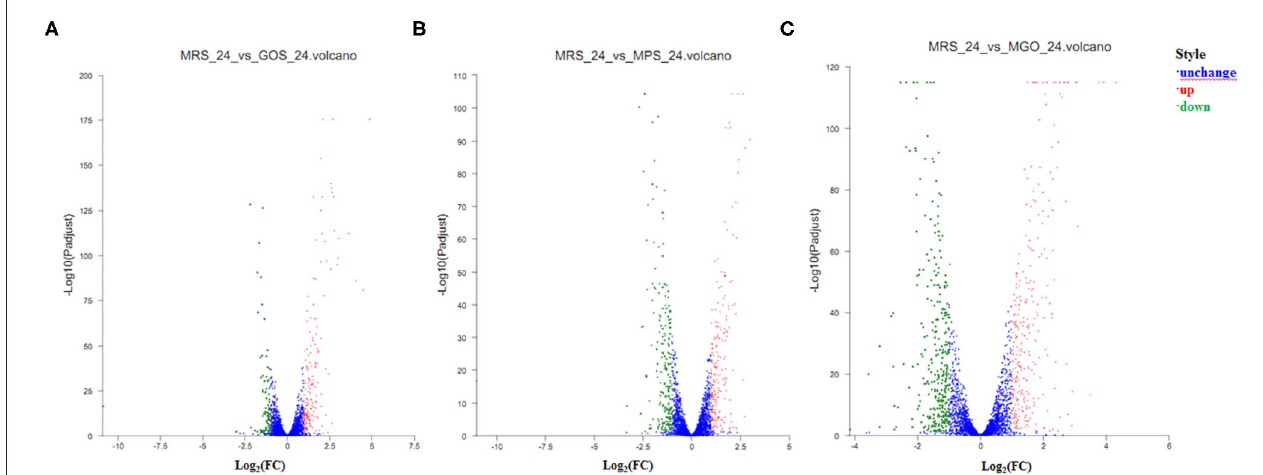
FIGURE 3 | Volcano plots of differentially expressed genes after different prebiotic treatments. Genes with differences in expression are shown in red (up-regulated) or green (down-regulated), and genes with no significant differential expression are shown in blue. The horizontal axis represents the change in gene expression in different samples. (A) GOS added to the MRS medium and culture for 24h; (B) MPS added to the MRS medium and culture for 24h; (C) MGO added to the MRS medium and culture for 24h.